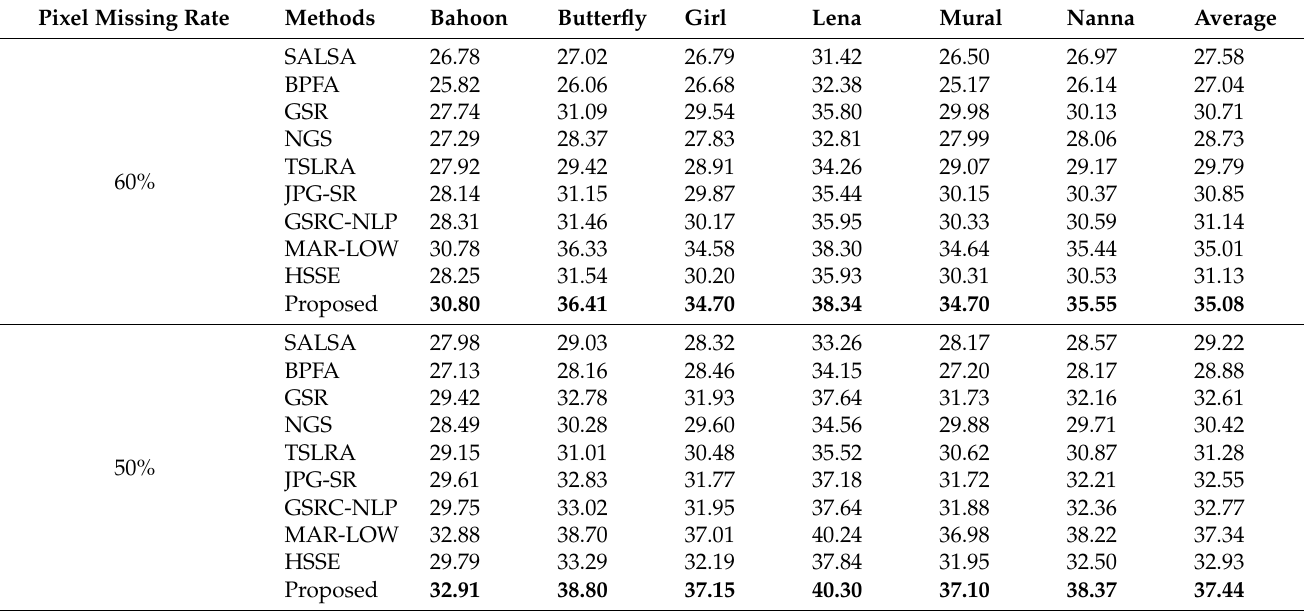
Table 2. PSNR values of the proposed method and some state-of-the-art methods with pixel missing rates 60% and